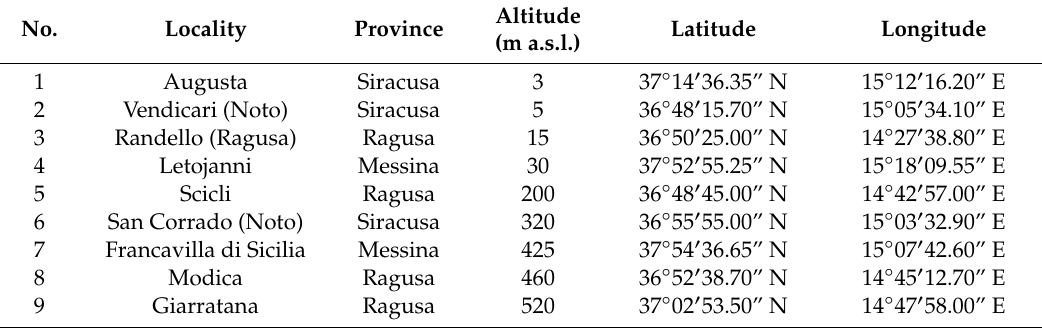
Table 1. East Sicilian sites where biological data on Glycaspis brimblecombei and climatic data were collected (reported in ascending order of